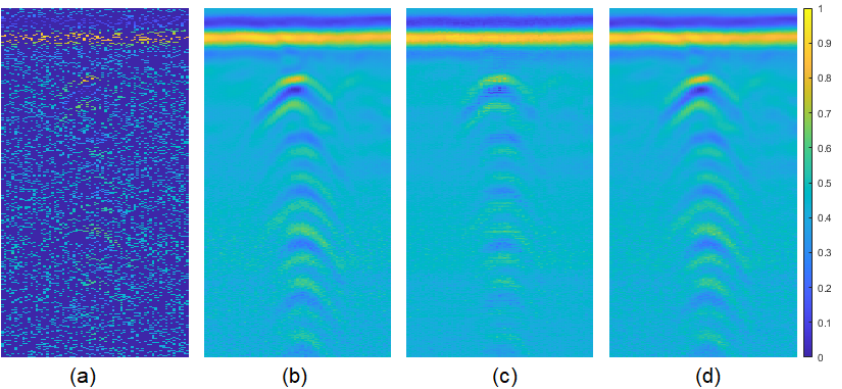
Figure 22. 80% pixel-wise missing data case for the zoomed target (third one) of real data-II: ( a ) GPR image with missing entries, ( b ) original GPR image, recovered images by ( c ) NNM zoomed , ( d ) DIP zoomed .